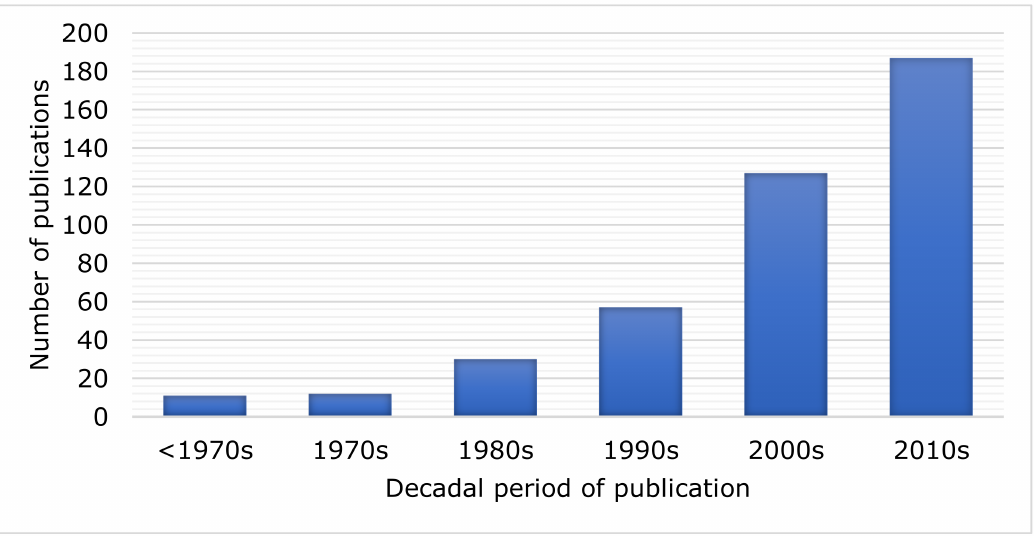
Figure 1. Number of articles published on Corvidae species in urban environments by decade ( n = 424). Most studies were carried out in Europe or North America (45.5% and 31.4%, respec- tively; n = 424), followed by Asia and Australia (14.6% and 4.5%), and there were only a few studies from Africa (2.1%; Table S3). Eight studies (1.9%) had a global study range. A total of 319 articles (75.2% of all 424 articles) were on a single species, 44 (10.4%) on two species, and 60 (14.2%) on more than two species, whereas 22 (5.2%) of the articles were community-level studies (Table